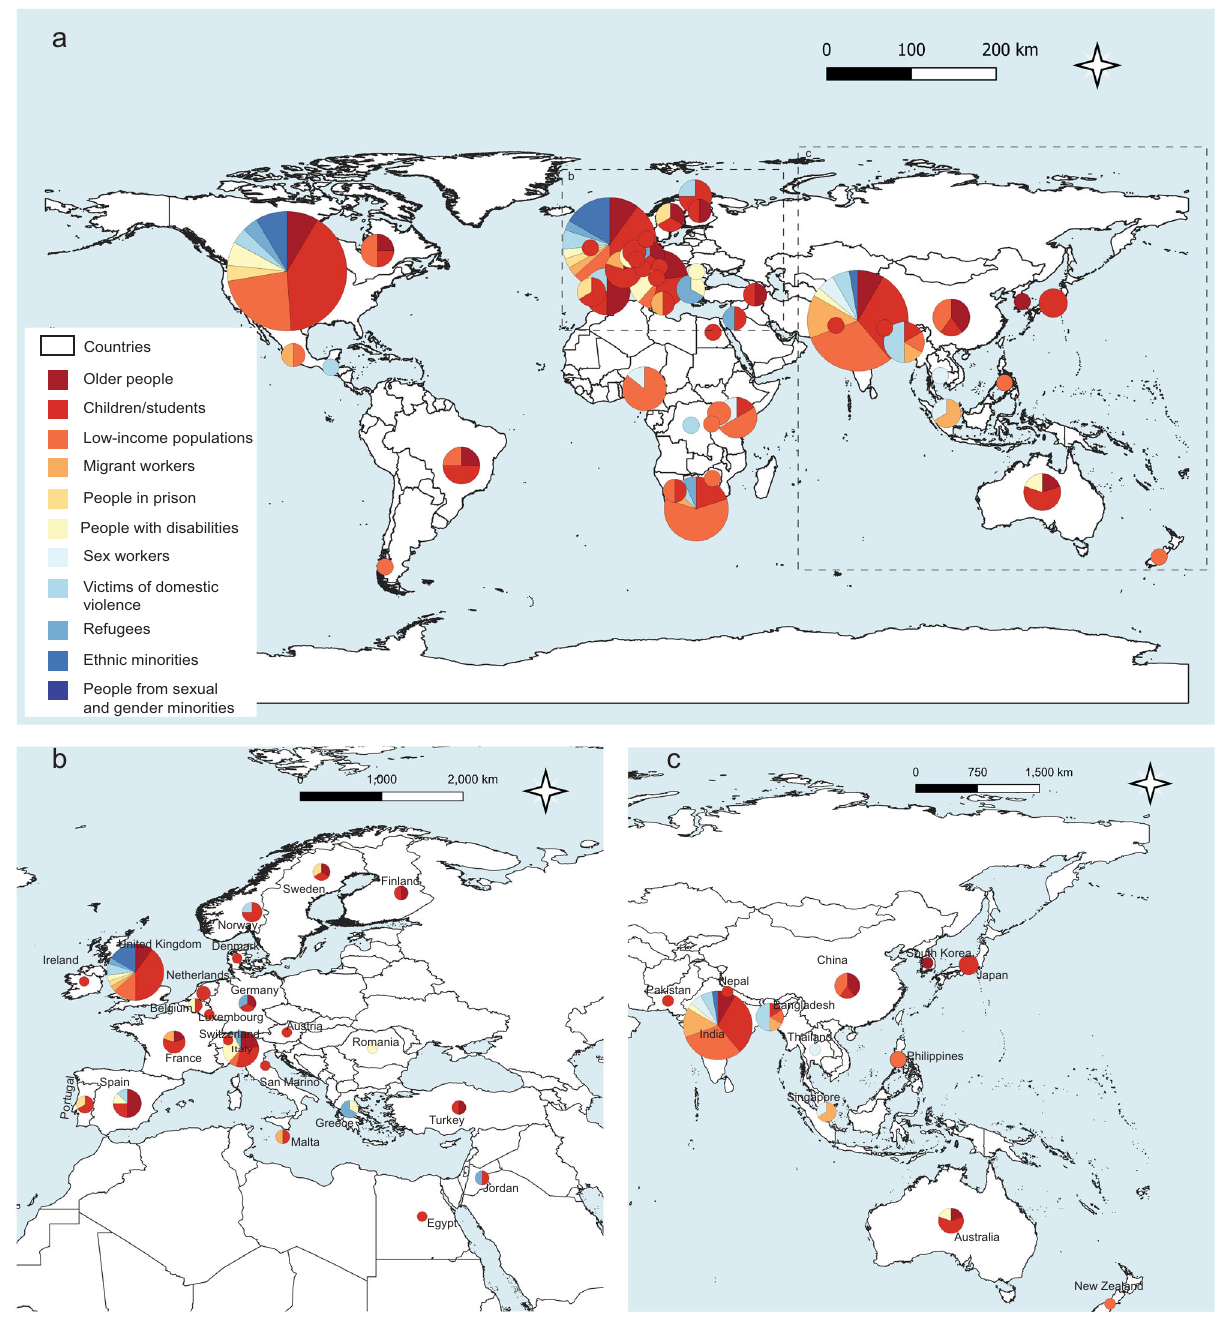
Fig. 2 | Distribution of included studies across countries and vulnerable groups. a Global map. b Data distribution around Europe. c Data distribution aroundAsia.DatalistedinSupplementaryTables5 –